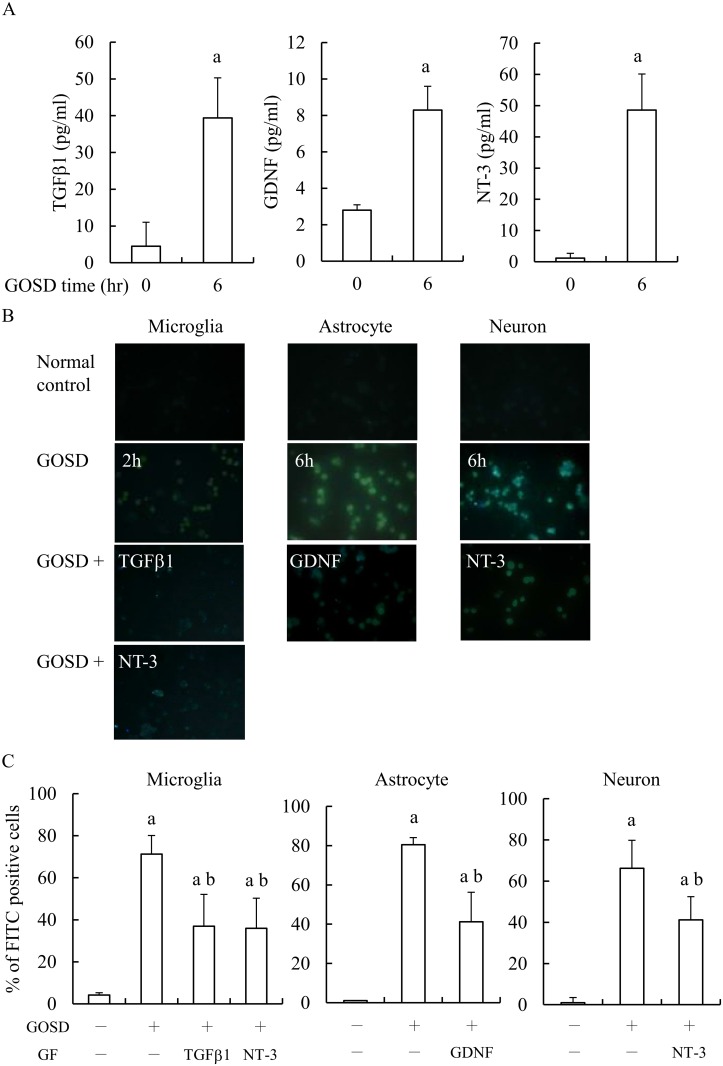
GOSD-induced TGFβ1, GDNF and NT-3 release from neurons can each protect brain cells from GOSD-induced apoptosis.Neurons (6.4x106/dish in 10-cm dish plates) were cultivated under GOSD condition for 0 and 6 h. At the end of each time point, NCM was collected and the amounts of TGFβ1, GDNF and NT-3 within the NCMs were determined by ELISA kits (A). Anti-apoptotic effect of 1 ng/ml of TGFβ1, GDNF or NT-3 on GOSD-treated microglia (for 2 h), astrocytes (for 6 h) and neurons (for 6h), were further determined by TUNEL assay. The images of FITC-positive cells (apoptotic cells) were captured under the fluorescence microscope (B) and percent of FITC-positive cells per visual field was further calculated and averaged from six randomly picked fields for each group (C). The magnification of images is 400X. aSignificant difference between lane 1and the indicated lanes; bbetween lane 2 and the indicated lanes, p<0.05. Each experiment was repeated for 3 times.